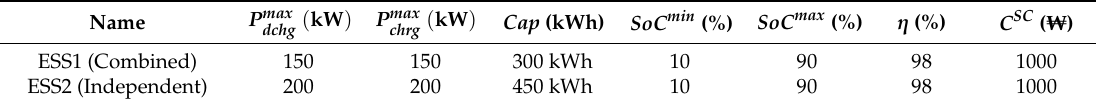
Table 1. Parameters of combined and independent ESSs.